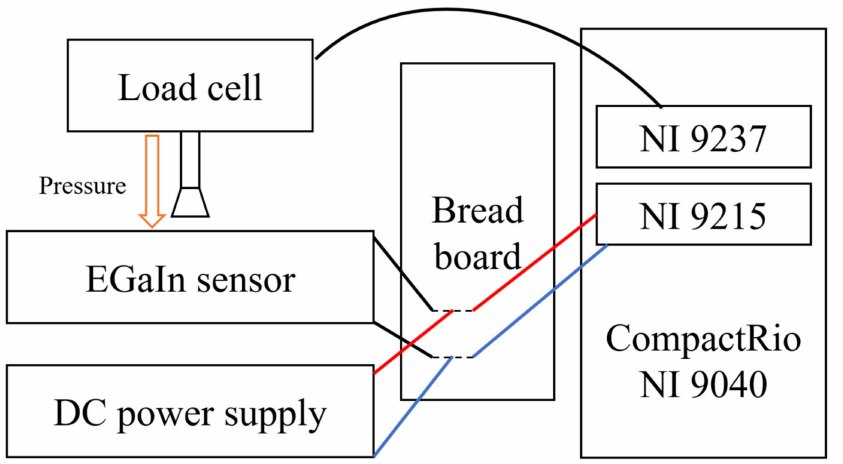
Figure 15. Illustrative schematic and connection diagram for the resistance measurement experiment.